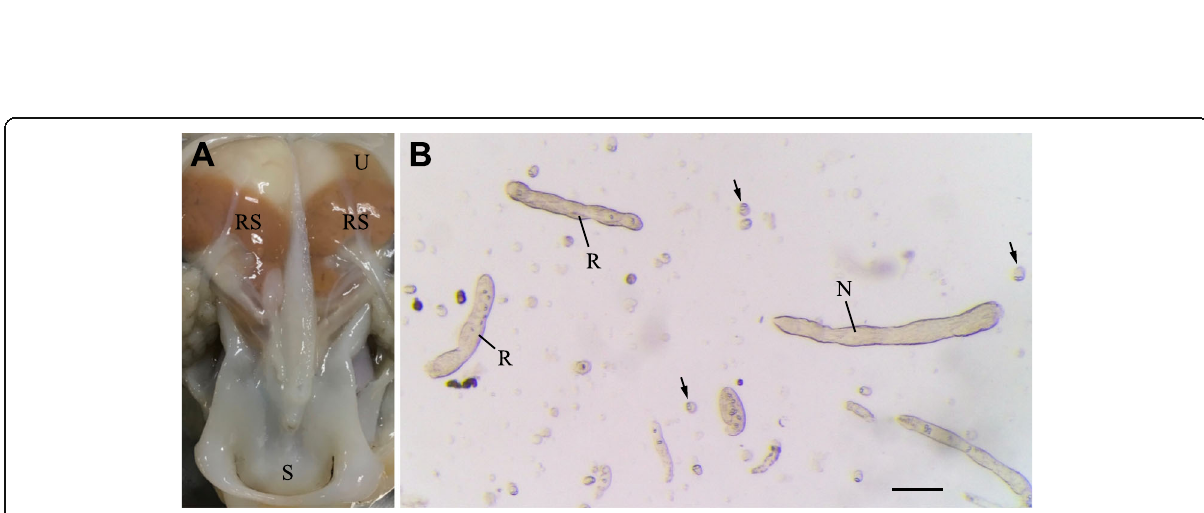
Fig. 2 Dicyemids are microscopic endoparasites inhabiting the renal sacs of octopuses. a Dissecting the renal system of an octopus. The renal sacs are full of urine, and dicyemids inhabit the renal appendages (orange tissue) inside the renal sacs. b Urine of an octopus drawn from the renal sac. Dicyemids at different life-cycle stages appear in the urine; therefore, samples of different life cycle stages had to be carefully isolated and sorted. N, nematogen; R, rhombogen; RS, renal sac; S, siphon; U, urine. Arrows, infusoriform larvae. Scale bars: 50 μ